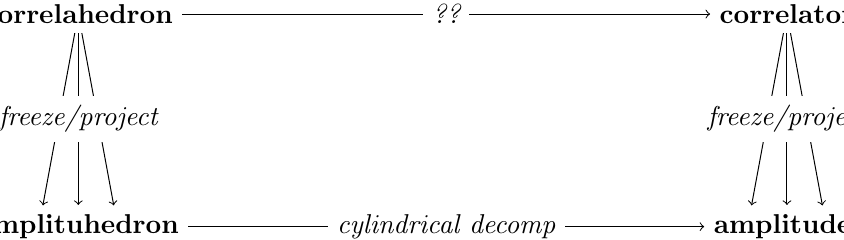
Figure 1 . Figure schematically illustrating the relationship between the correlator and amplitude (squared) as well as the corresponding relation between the geometric objects, the correlahedron and (squared)